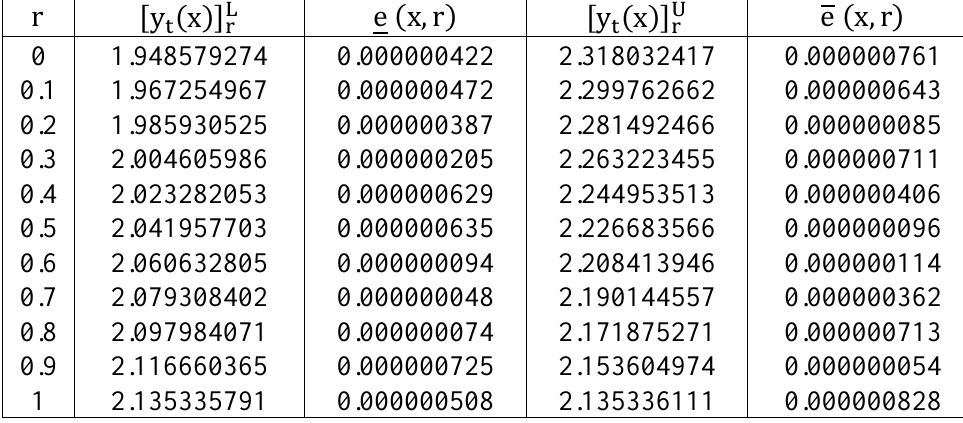
Table (1): Trial solutions for example (1), x = 2.